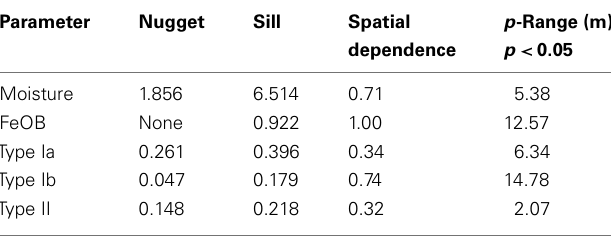
Table 3 | Parameters for geostatistical analysis of log-transformed qPCR data of FeOB and MOB taxa and percentage of moisture